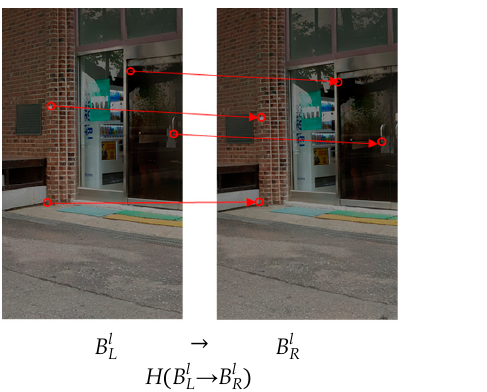
→ B l ) and H ( B r → B r ) are calculated by applying the feature extraction algorithm L L R R ) R